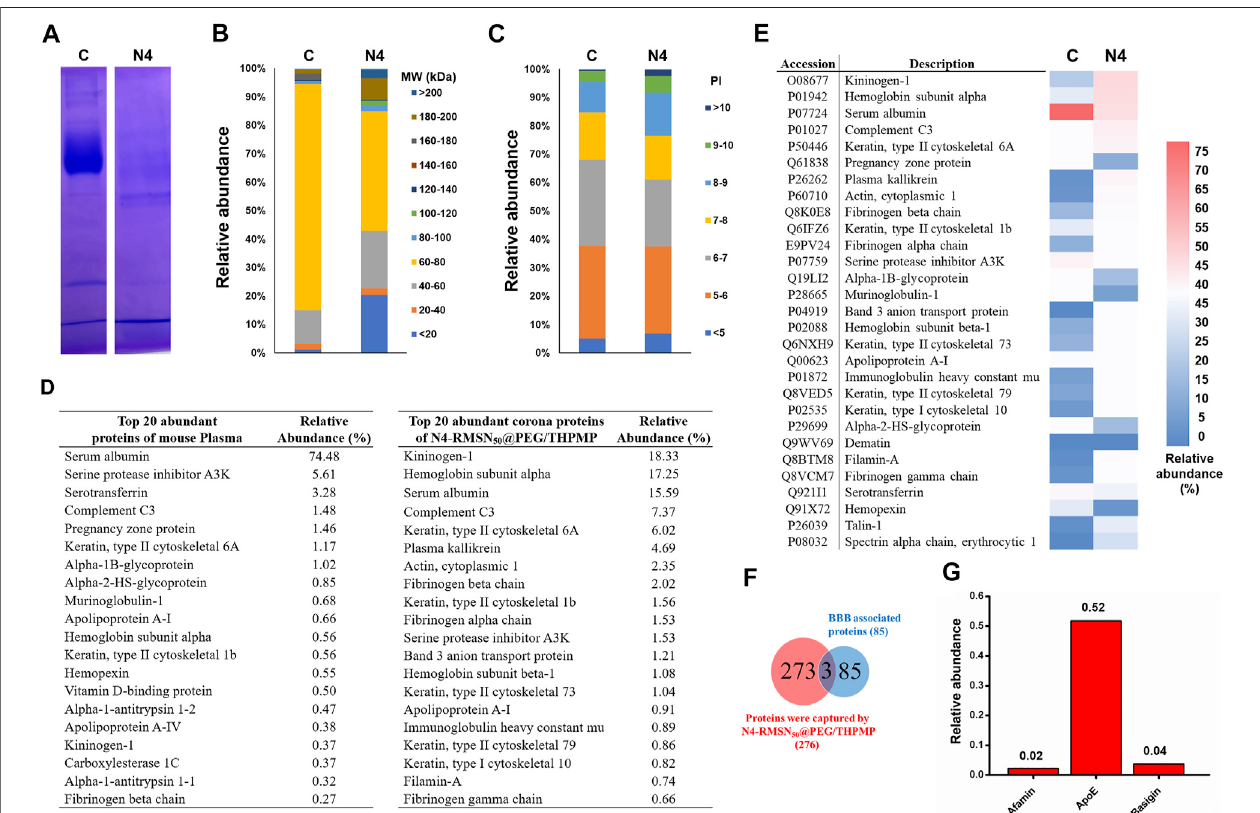
FIGURE7| Comprehensiveproteincoronaidenti fi cationofN4-RMSN 50 @PEG/THPMPincubated withmouseserum byLC-Ms/MS. (A) SDS-PAGEgelofplasma (control) and corona proteins associated with N4-RMSN 50 @PEG/THPMP. (B) Classi fi cation of corona protein according to (C) molecular weight. and (D) isoelectric point.Themostabundantproteins(top20)aresummarized. (E) Heatmapofthemostabundantproteins. (F) Venndiagramsreportthenumberofproteincoronaandthe proteins related to BBB transport. (G) Relative abundance (vs mean abundance) of BBB transport associated proteins identi fi ed in the protein corona. C: